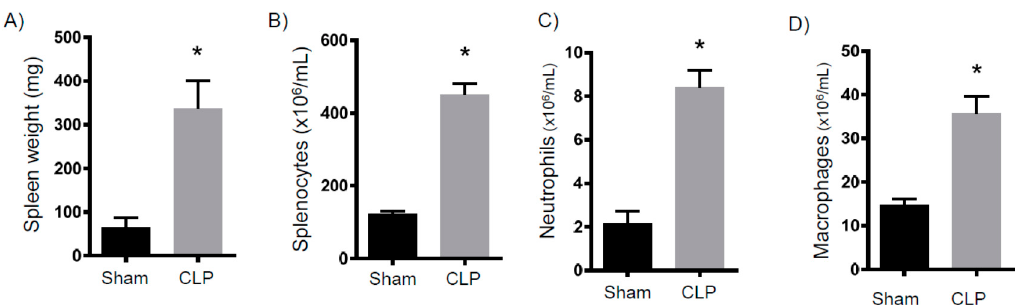
Figure 2. Splenic myelopoiesis eight days after CLP. Mice were subjected to either sham surgery ( N = 14) or CLP ( N = 20). Eight days later, animals were sacrificed and their spleens were analyzed for ( A ) weight, ( B ) total number of WBCs, ( C ) neutrophils, and ( D ) macrophages. * p < 0.05 versus sham.